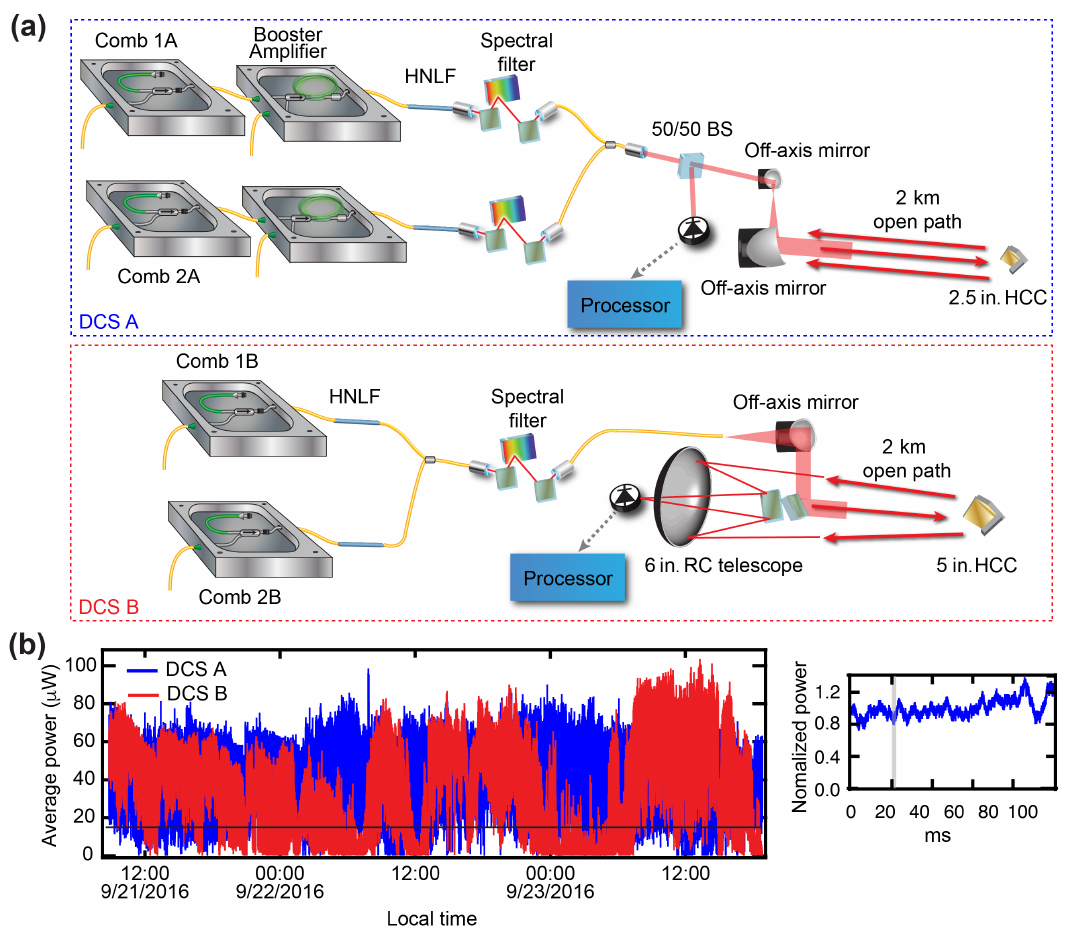
Figure 3. (a) Configuration of DCS A and DCS B, both of which are based on fully self-referenced fiber-laser frequency combs. See text and Table 1 for details. DCS A includes booster amplifiers for higher launched optical power than DCS B. (b) Average optical return power for DCS A (blue) and DCS B (red) measured at the detector over about 2.5 days. The horizontal black line shows the approximate minimum power for useable SNR (15µW). Right-hand side: the normalized power fluctuations for DCS A over 100ms. The fluctuations are from turbulence and have a characteristic timescale much longer than the acquisition time for a single DCS spectrum, shown by the thickness of the vertical grey bar, and therefore do not lead to overall distortions in the spectrum. RC: Ritchey–Chrétien; HNLF: highly nonlinear fiber; HCC: hollow corner cube retroreflector; BS: beam